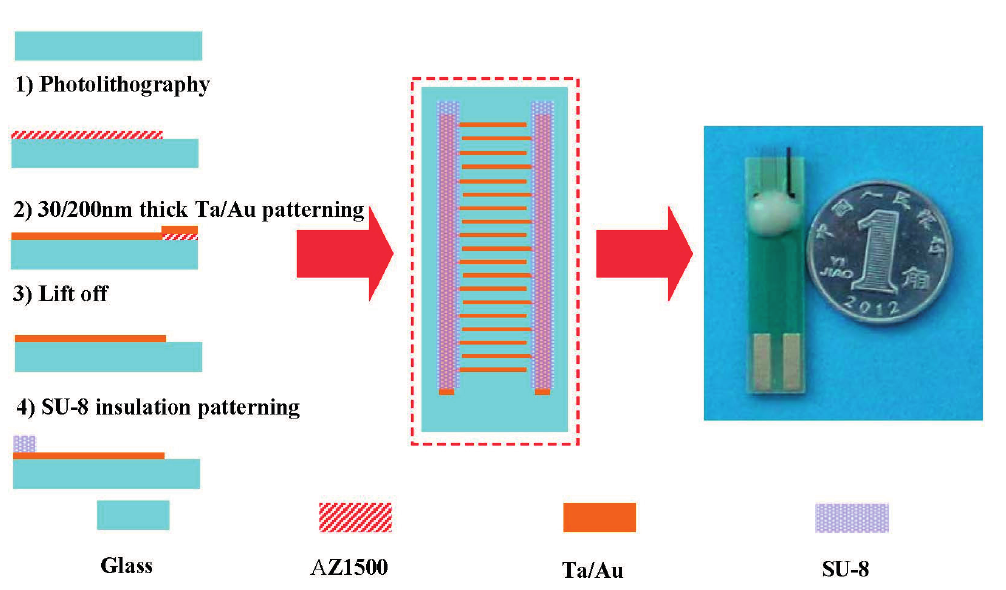
Figure 1. The fabrication process and a photograph of a gold MAE (coin diameter 19